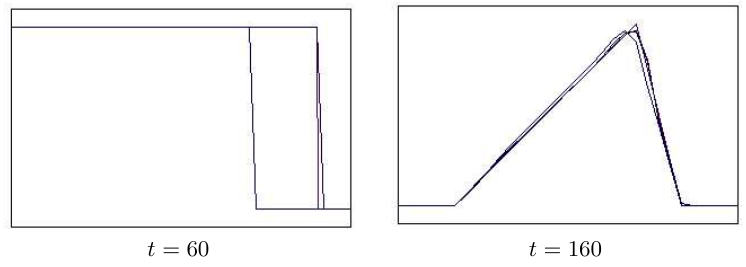
Figure 8. Numerical solution for the jumping advection method for 3 initial data ( (cid:13) = 0 : 5; 0 : 9